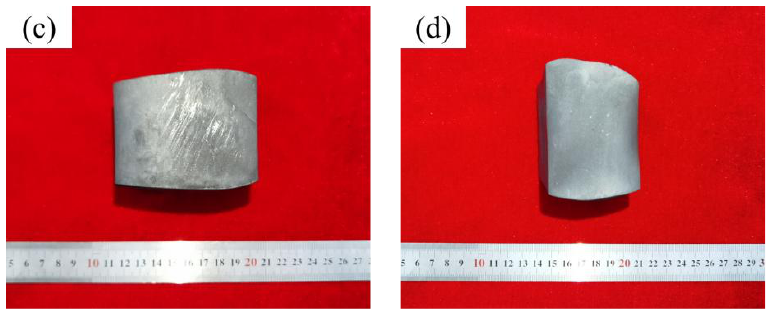
Figure 6. The morphology of the upsetting samples: ( a ) 0%; ( b ) 17.46%; ( c ) 38.19%; ( d ) 58.16%.